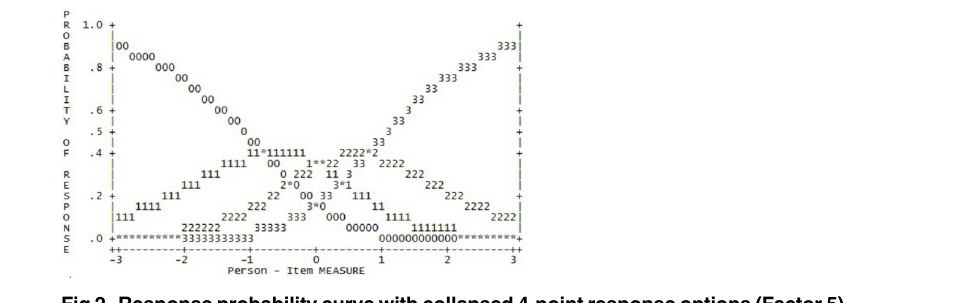
Fig 2. Response probability curve with collapsed 4-point response options (Factor